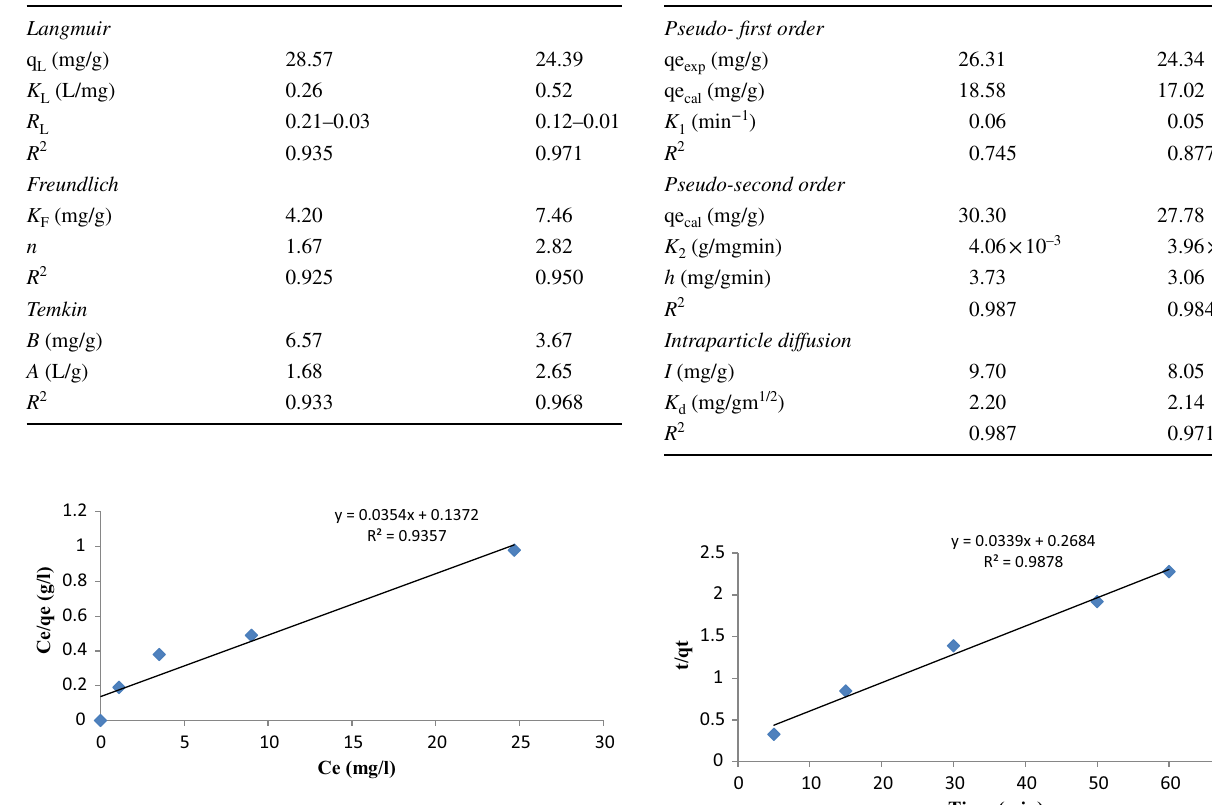
Table 2 Equilibrium isotherm parameters for Pb 2+ and Cd 2+ adsorp- tion by studied soil Parameters